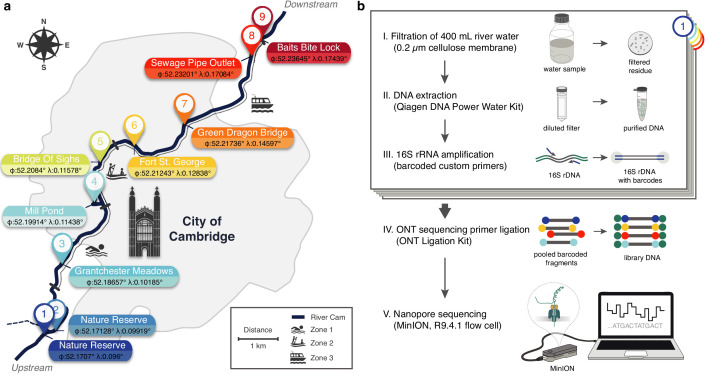
Freshwater microbiome study design and experimental setup.(a) Schematic map of Cambridge (UK), illustrating sampling locations (colour-coded) along the River Cam. Geographic coordinates of latitude and longitude are expressed as decimal fractions according to the global positioning system. (b) Laboratory workflow to monitor bacterial communities from freshwater samples using nanopore sequencing (Materials and methods).